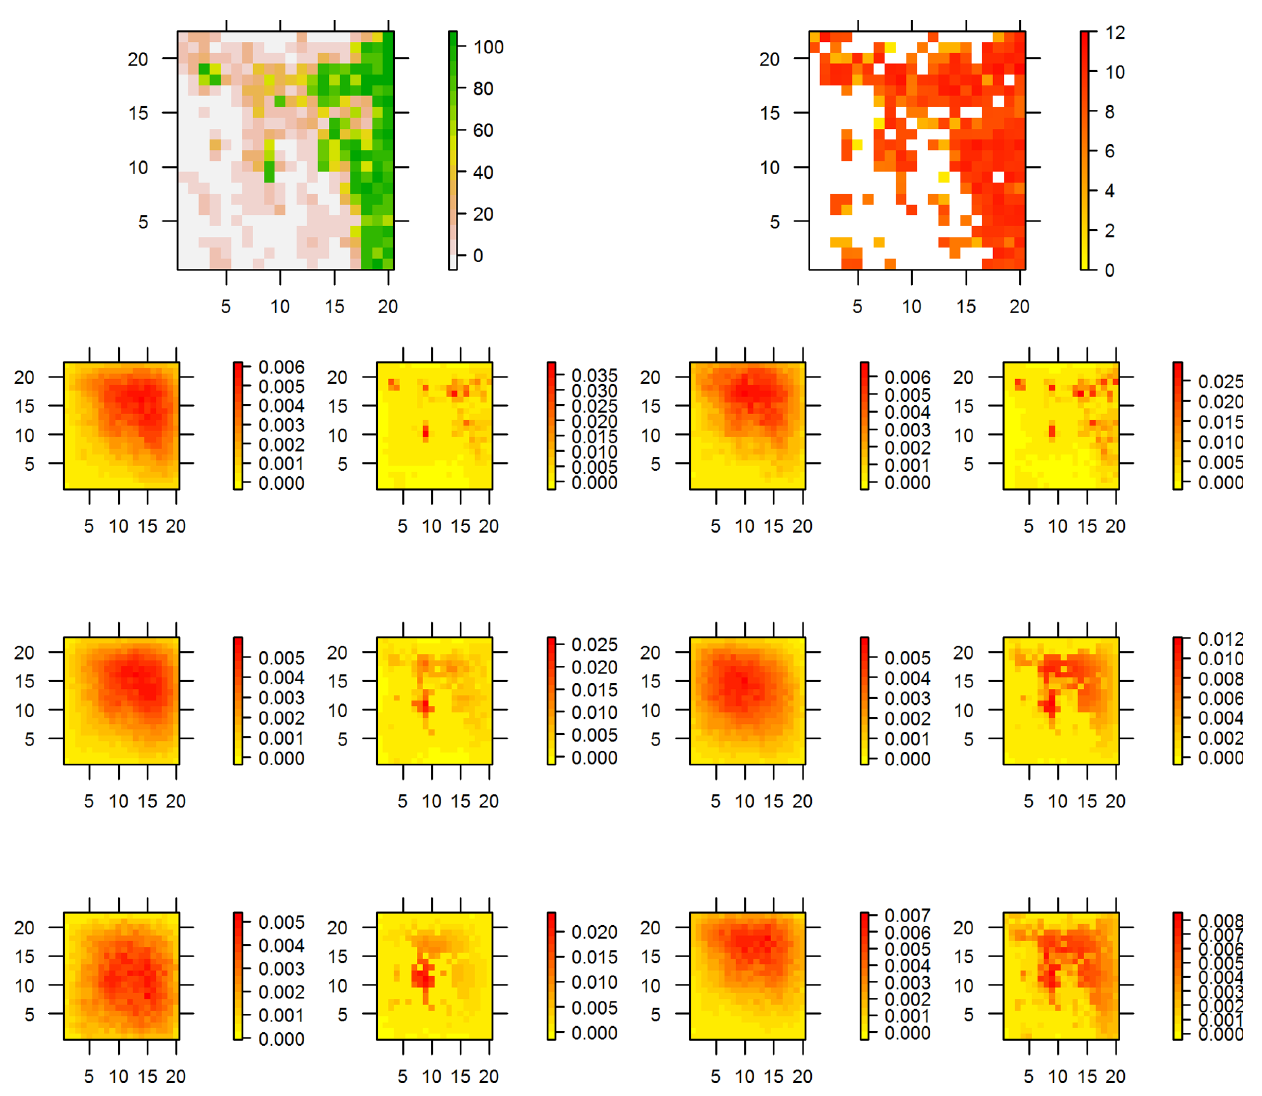
Figure 3. Cover, fruit abundance and maps of simulated seed rain by each bird species. Seed rain maps hold the proportion of seeds dispersed to each landscape cell by each bird species. The left column under each species is for a ‘‘distance-only’’ model and the right one for the ‘‘full’’ model including biases due to forest cover and fruit abundance.